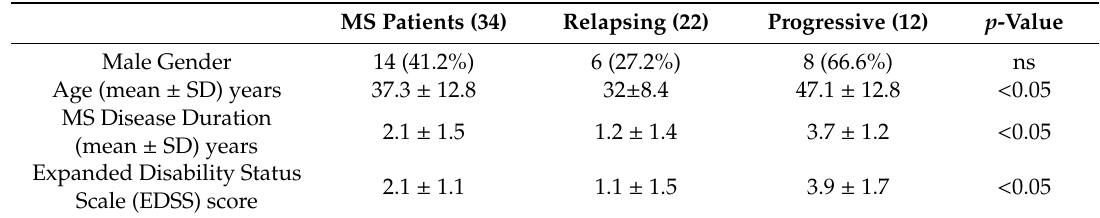
Table 1. Demographic and clinical features of multiple sclerosis (MS) patients included in the